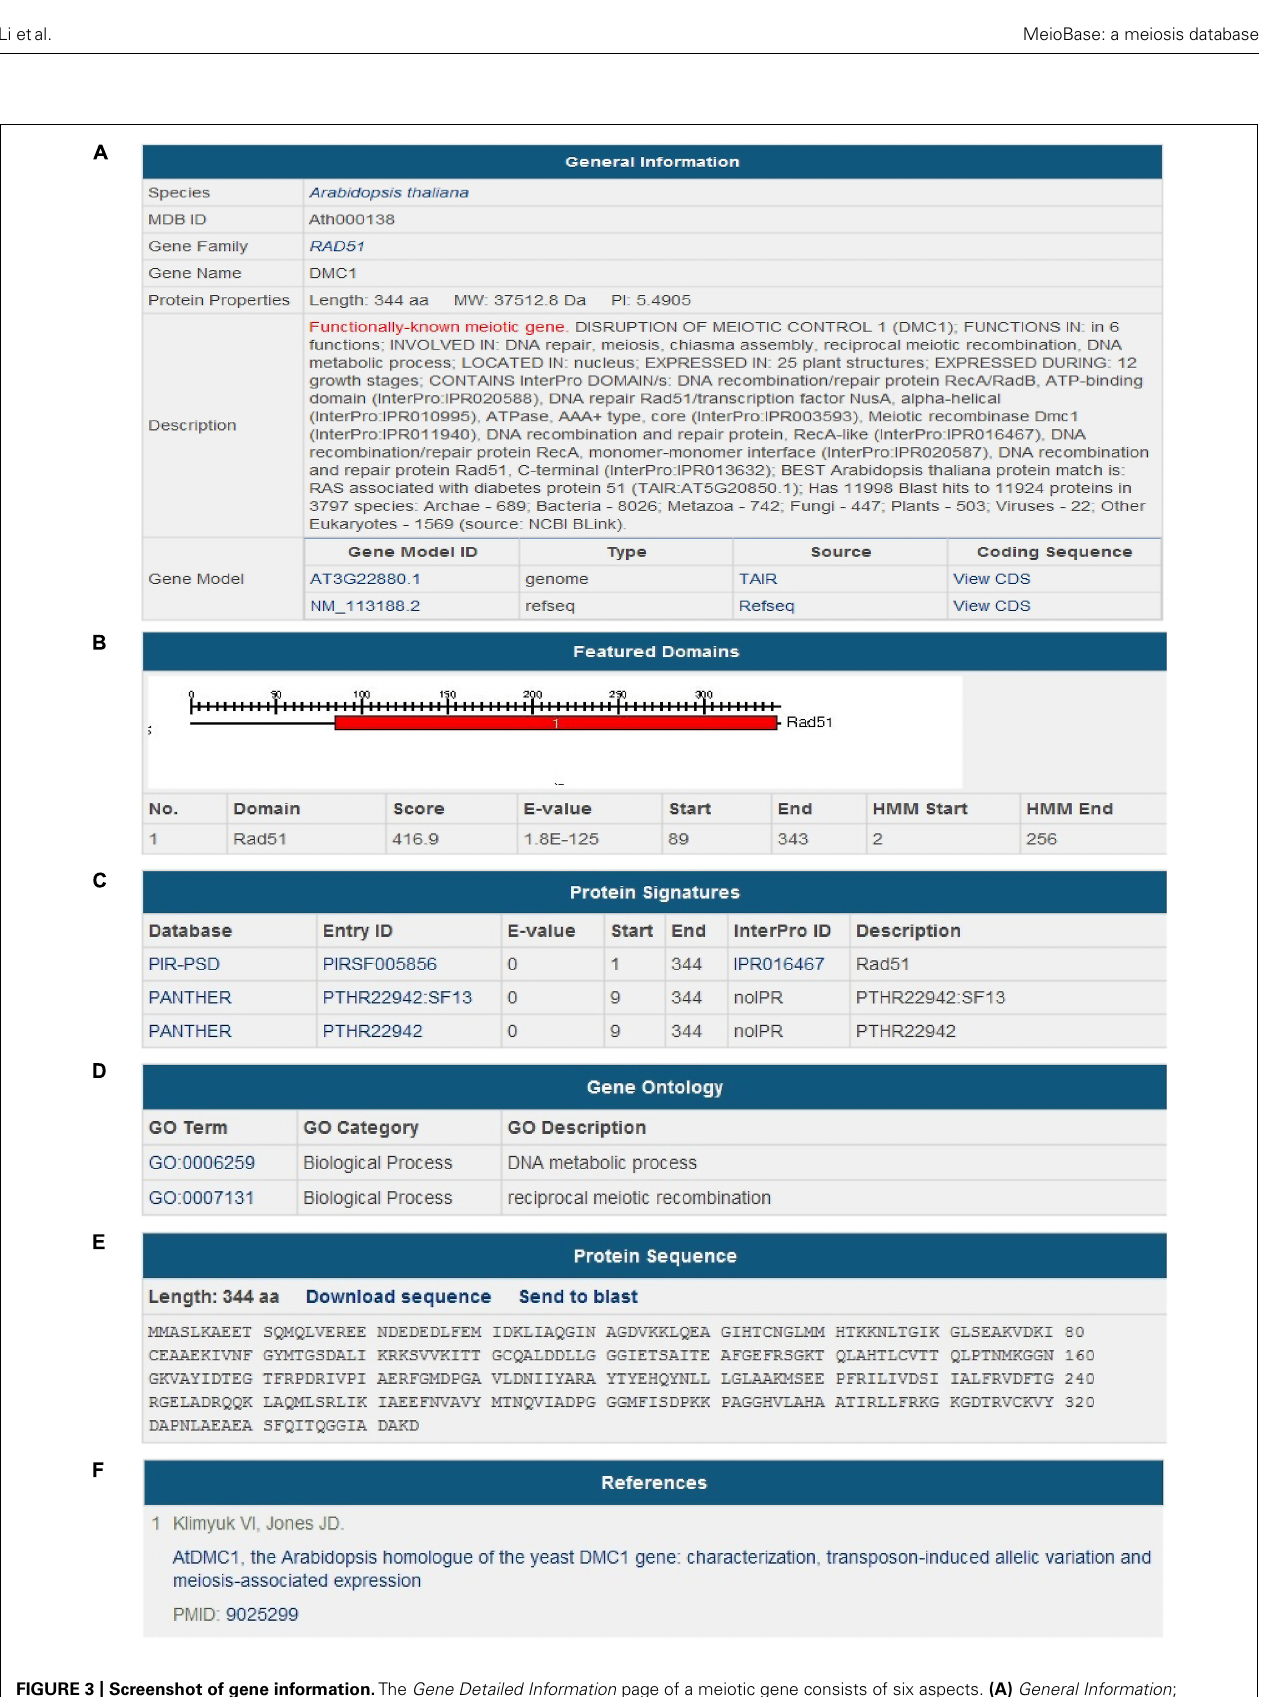
Frontiers in Plant Science | Plant Evolution and